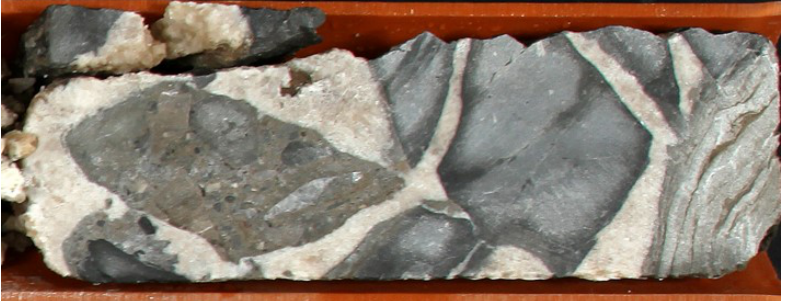
Figure 3. Core plug sample photo of angular breccia. Interval of cave roof collapse in the Loppa High